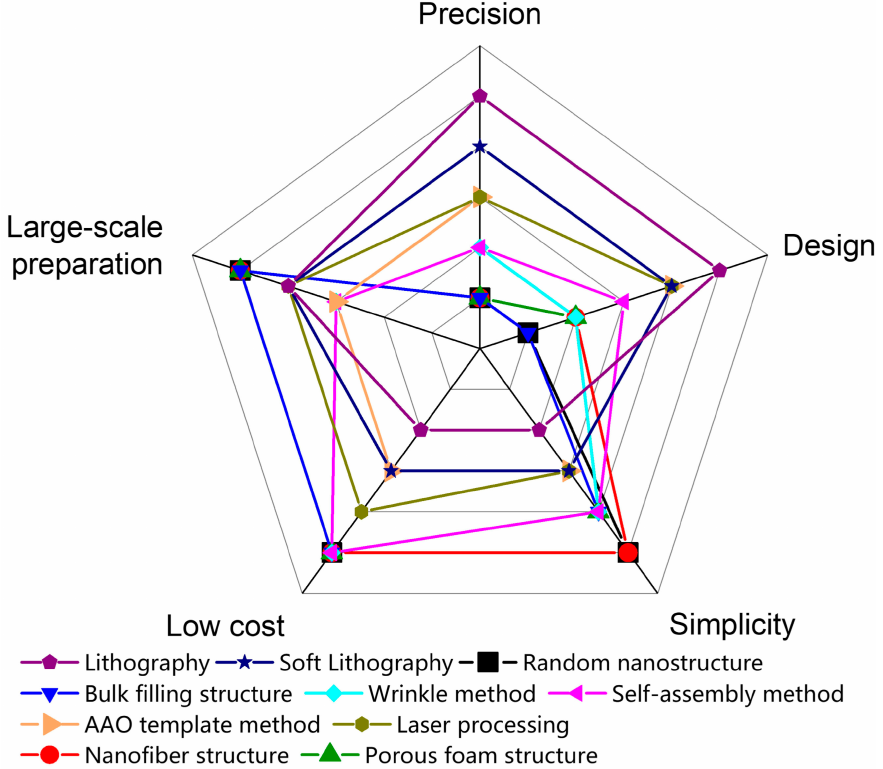
Figure 5. Comparison between the preparation methods of force-sensitive interface microstructures in flexible pressure